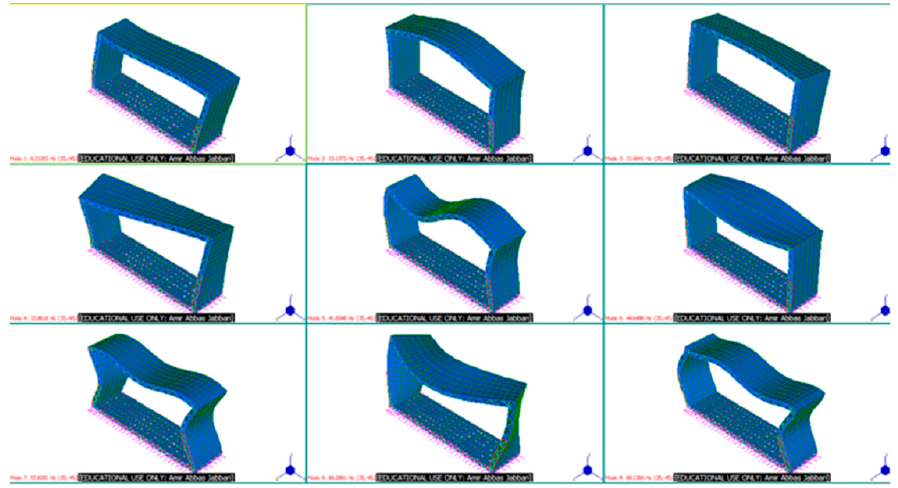
Figure 10. Deformed shape of the building associated with each mode. The deformation of the structure was investigated by obtaining the maximum nodal displacement in the vertical and lateral directions for each of the modes, as summarised in Figure